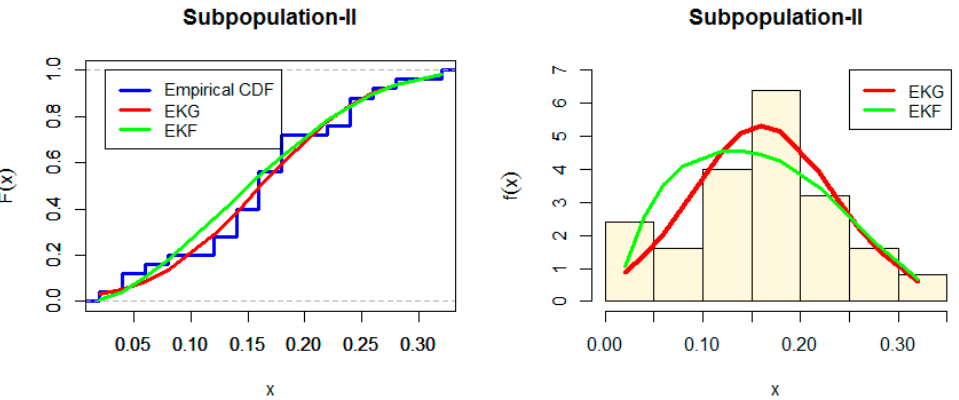
Figure 3. Estimated CDF and PDF for EKG and EKF distribution for Subpopulation II.